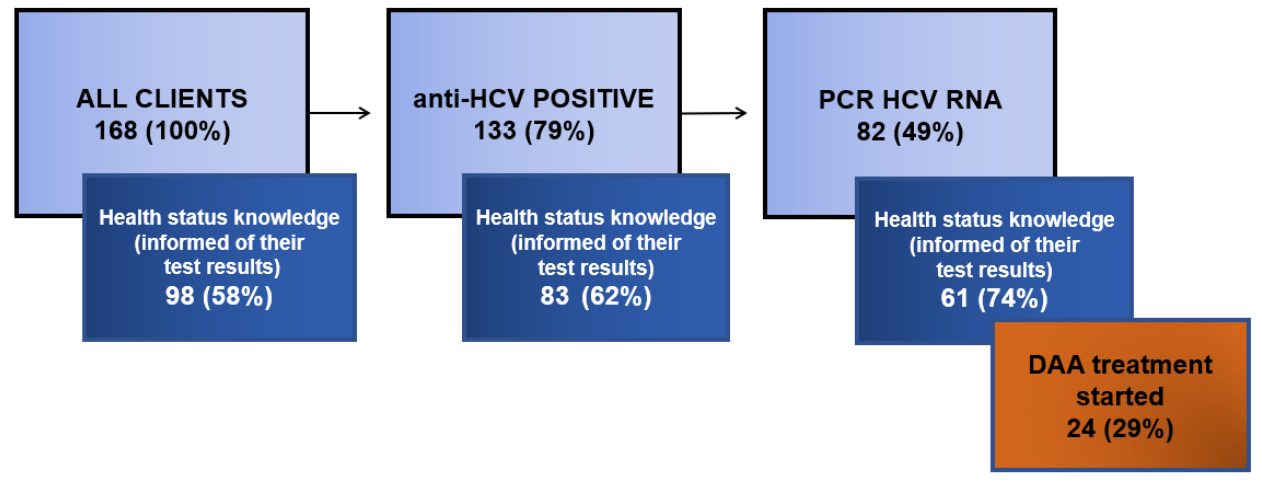
Figure 3. All tested clients in proportion to those who received their test results and were aware of their HCV infection.